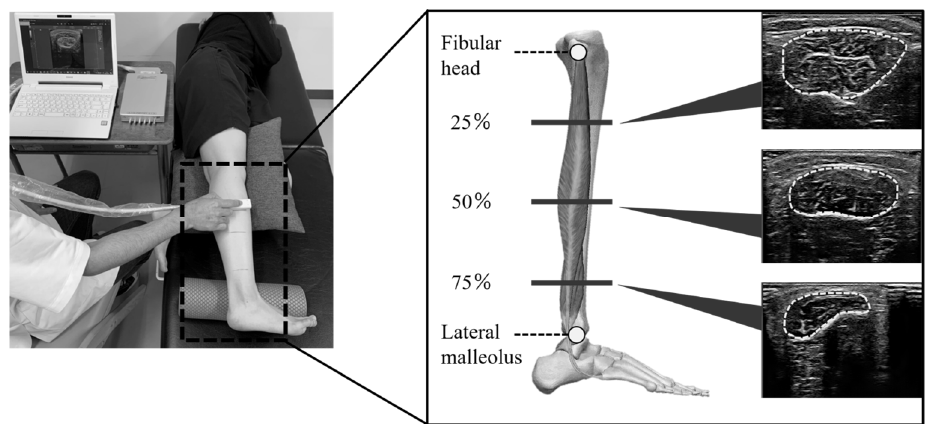
Figure 2. Measurement points of peroneus muscles by ultrasonography. The measurement points were the proximal 25%, central 50%, and distal 75% of the straight line connecting the fibular head and the lateral malleolus.